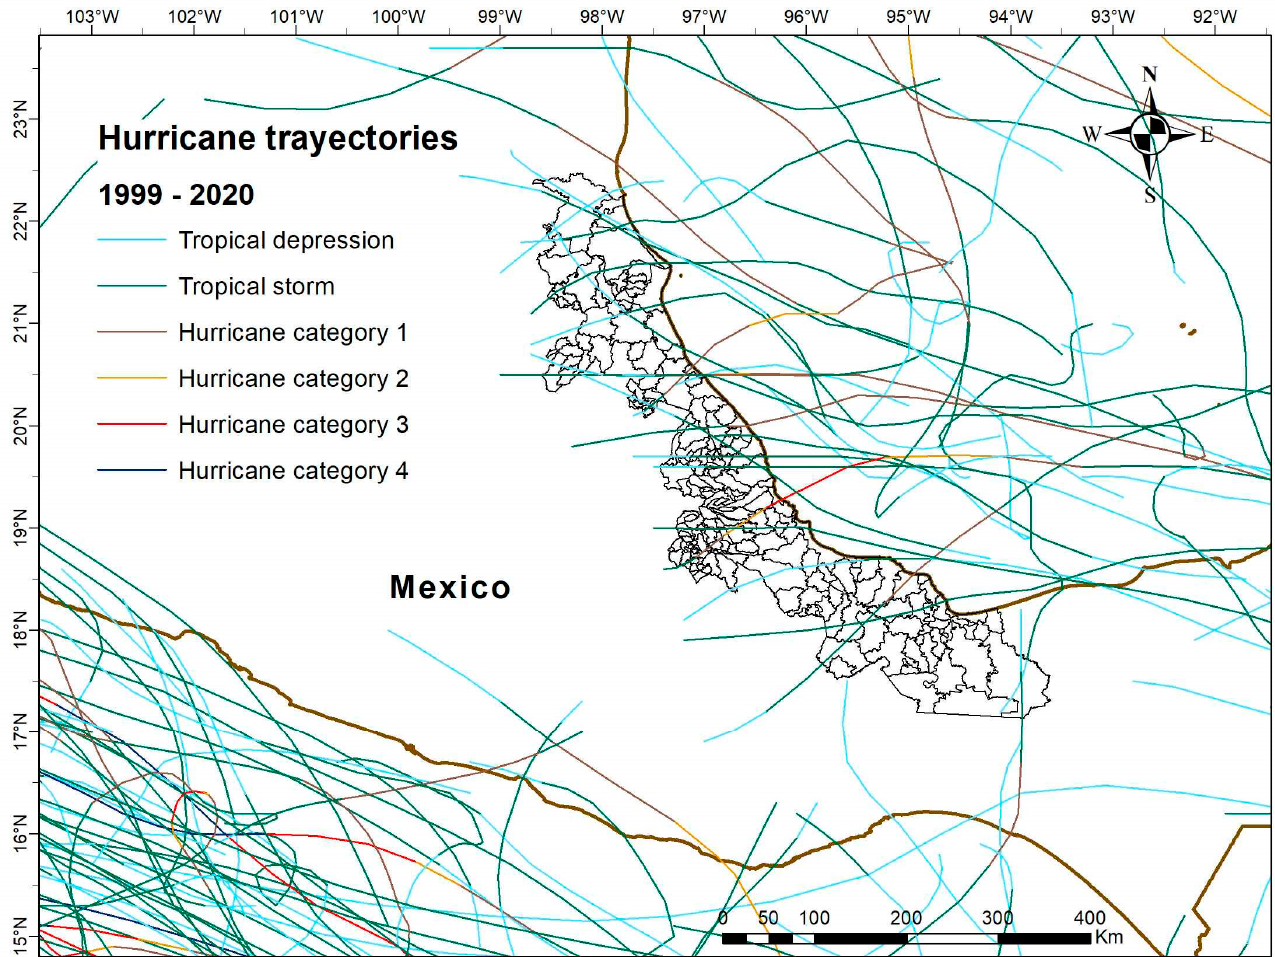
Figure 13. Tracts of tropical cyclones affecting the State of Veracruz from 1999 to 2020. Line colors indicate their category: light blue = tropical depression, green = tropical storm, grey = hurricane category 1, orange = hurricane category 2, red = hurricane category 3, and dark blue = hurricane category 4. Source: graphical representation obtained with data provided by the NOAA [34].